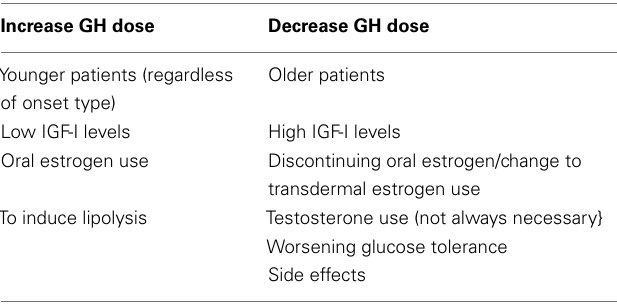
Table 4 | Factors that may affect GH dosing [adapted fromAACE 2009 (Cook et al., 2009)].